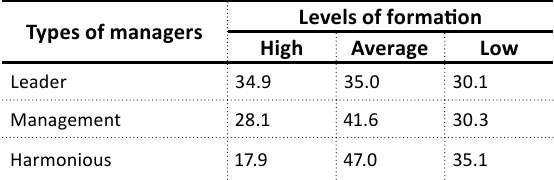
Table 1. Level of formation of types of educational institutions managers according